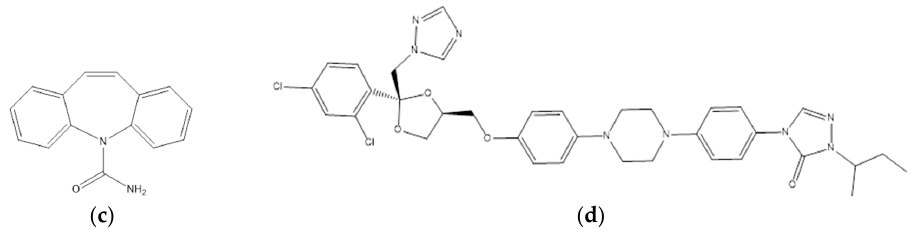
Figure 1. Chemical structure of ( a ) Ibuprofen; ( b ) Naproxen; ( c ) Carbamazepine; and ( d ) Itraconazole.